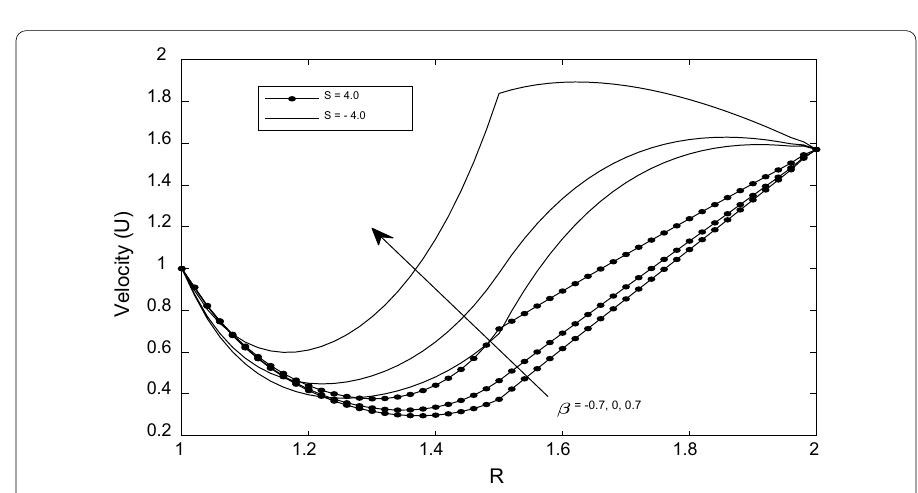
0.2, P 10,Da 0.2, d 1.5, A ∗ = = = =